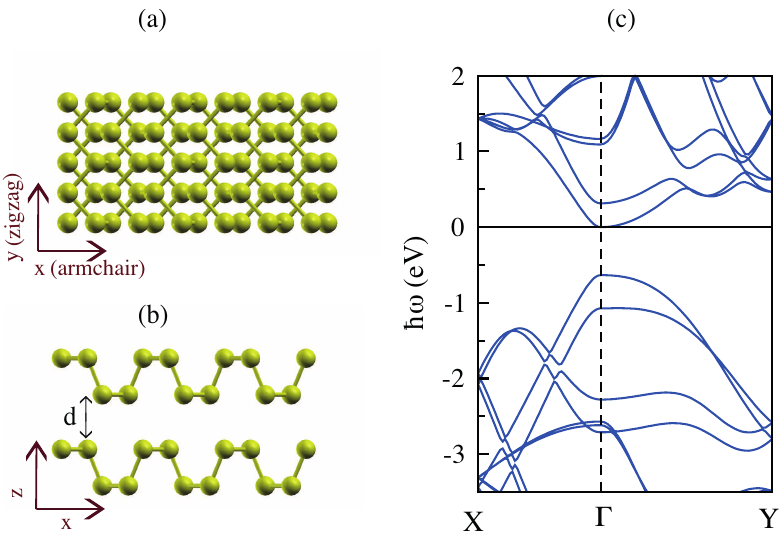
Figure 19. ( a , b ) Top and side view of the atomic structure of bilayer phosphorene (BLP). ( c ) The band structure of bilayer phosphorene along the high symmetry X − Γ − Y directions. The Fermi level is set at 0 eV. The optimized interlayer separation between the closest phosphorus atoms is indicated with d , being 3.56